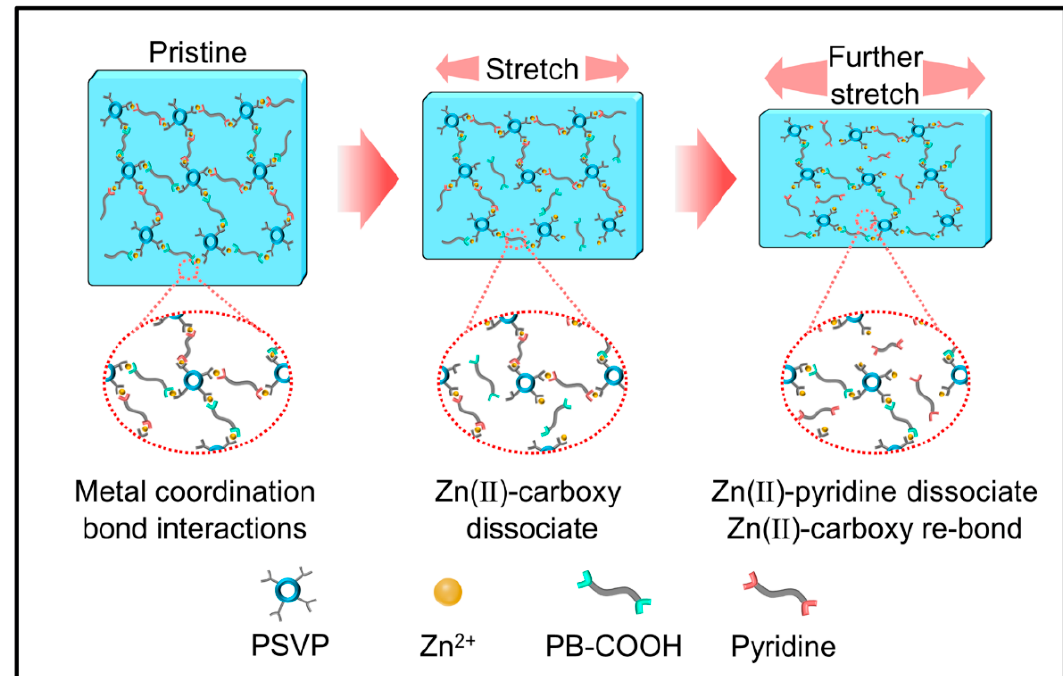
Figure 7. Schematic illustration of the self-healing mechanism.